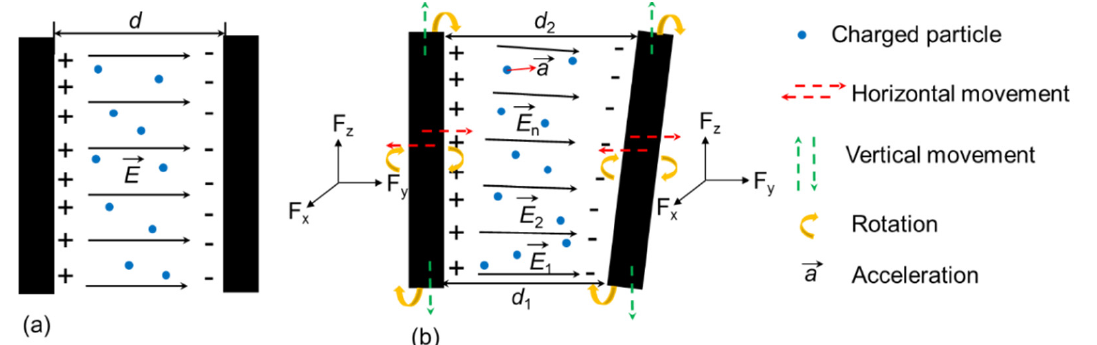
Figure 14. Schematic of the electric field and interface movement between microelement interfaces in the coal mass. ( a ) Uniform electric field and ( b ) changing electric field.